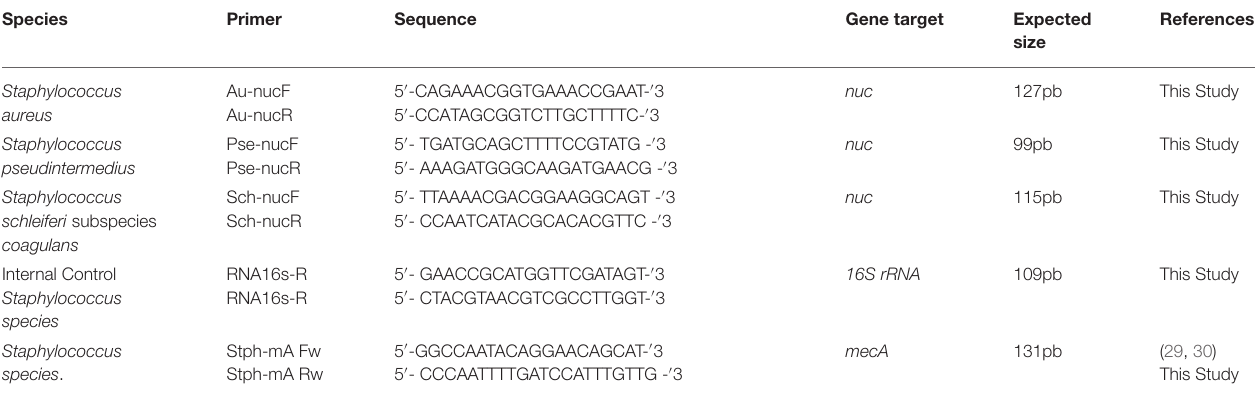
TABLE 3 | Oligonucleotide sequence and conditions used for Staphylococci amplification of the nuc gene of bacteria isolated from dogs with superficial pyoderma.